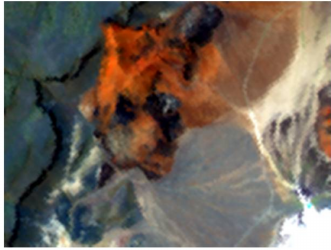
Figure 24. The sub-image of rotated LCVF (R 1453.49 nm, G 990.25 nm, B 547.20